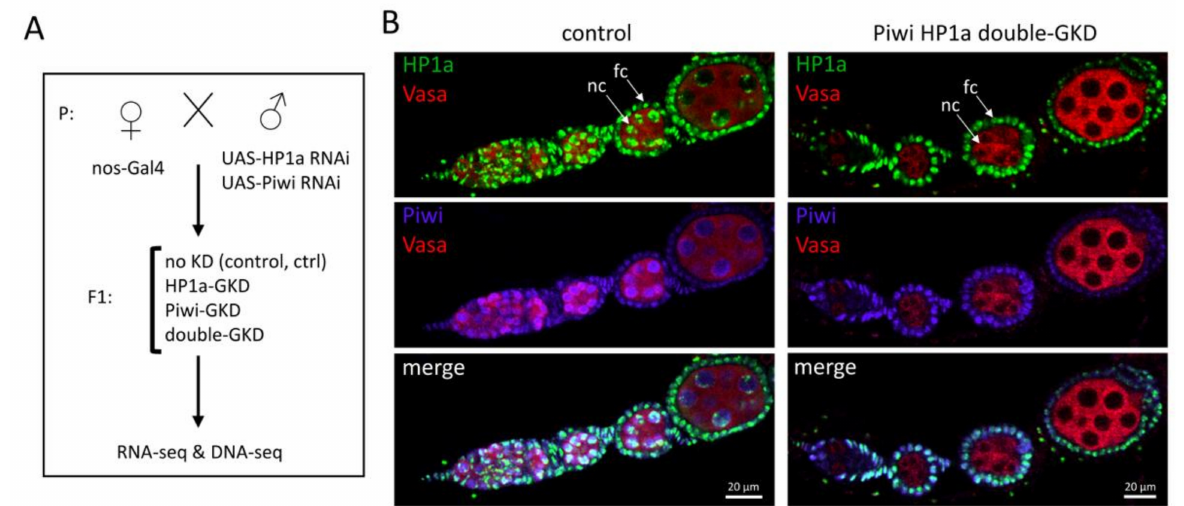
Figure 1. Generation of Piwi and HP1a separate and double-germline knockdowns. ( A ) Experimental design of the study. Control (no KD) flies and individuals with nos-GAL4 -driven germline knockdowns (GKD) of Piwi and HP1a and the Piwi/HP1a double-GKD were obtained simultaneously from the same cross. ( B ) Control and double-GKD ovarioles immunostained for HP1a (green), Piwi (purple) and germ cell marker Vasa (red). Examples of germline nurse cells and somatic follicle cells are indicated as “nc” and “fc”,